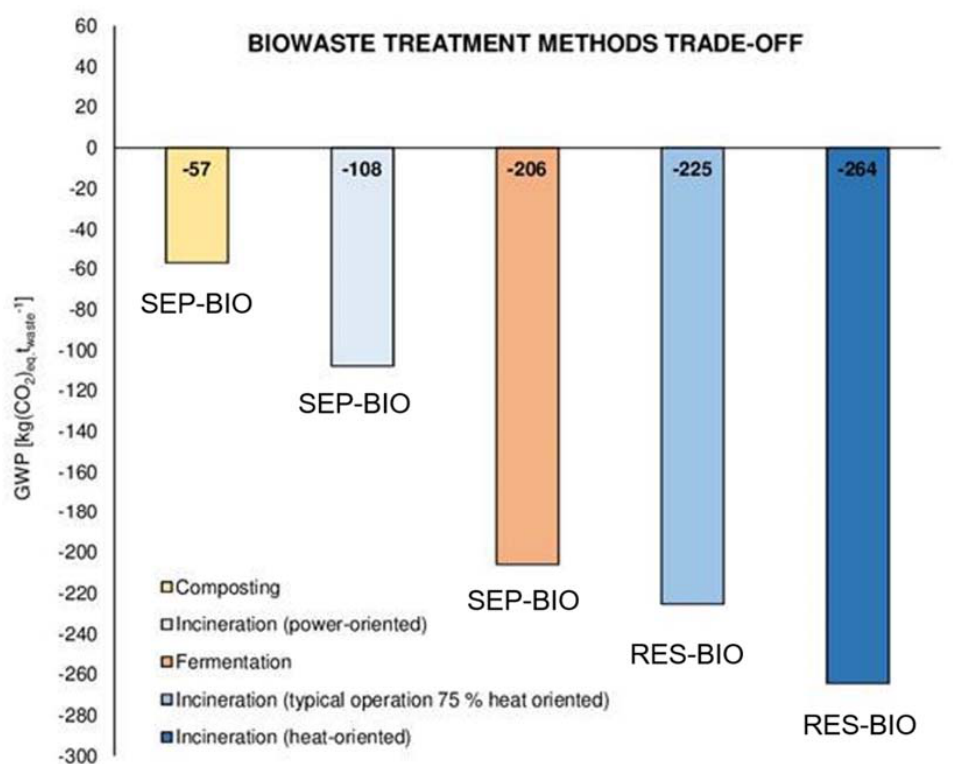
Figure 9. Biowaste treatment methods’ comparison, SEP ‐ BIO and RES ‐ BIO alternatives.